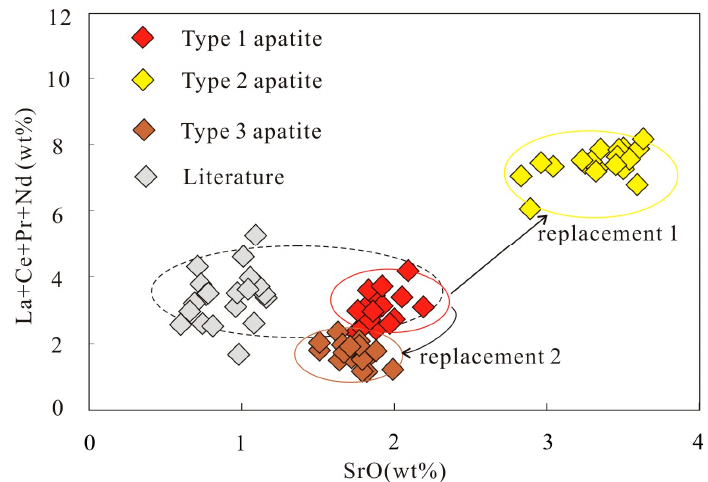
Figure 8. Plots of ( a ) CaO vs. (LREE 2 O 3 + SrO + Na 2 O) and ( b ) Na 2 O vs. LREE 2 O 3 for the three types of apatite.